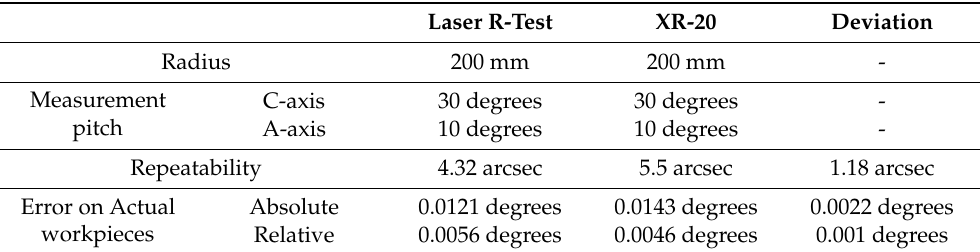
Table 2. System specification